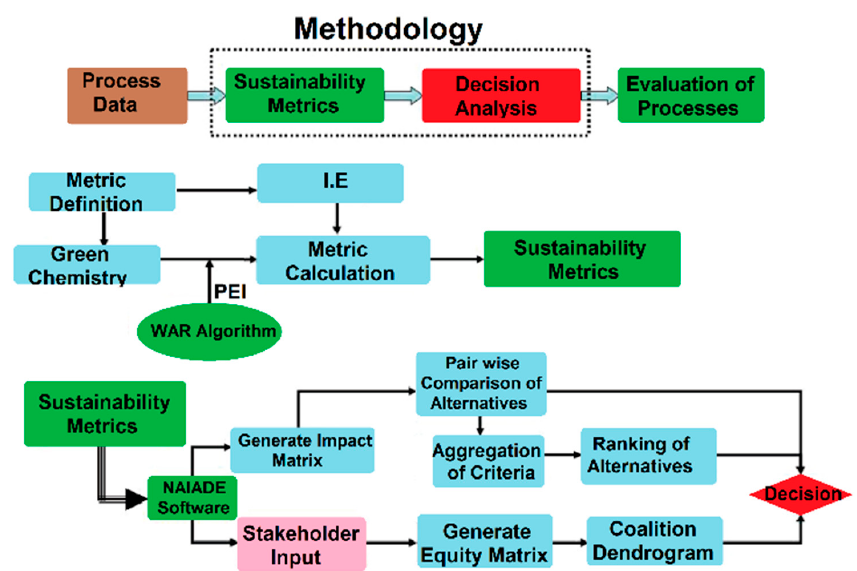
Figure 1. Principal components of the methodology. Adapted from Ref. [63].